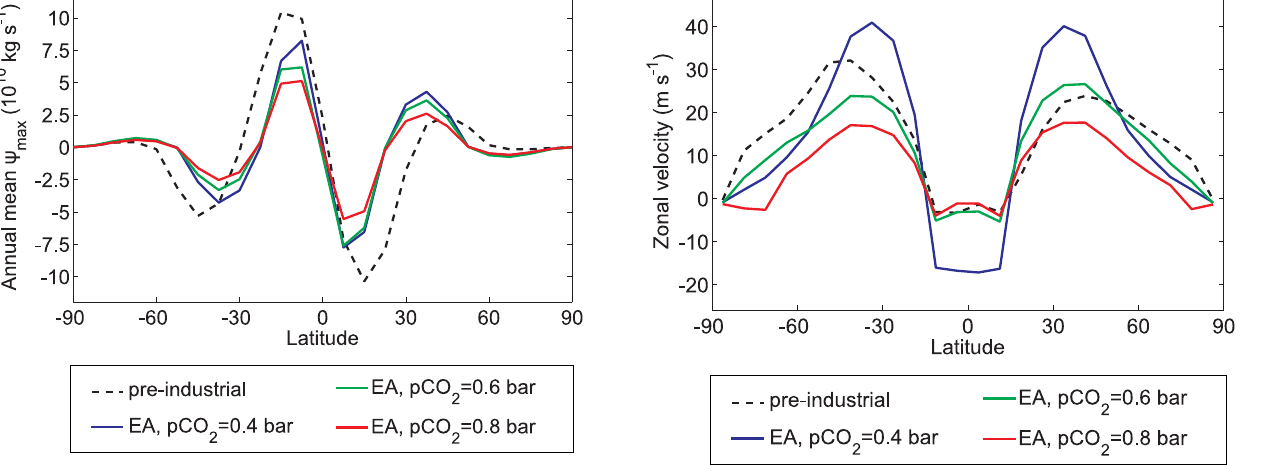
Fig. 12. Latitudinal profile of the annual-mean zonal wind maxima (taken with respect to height) for the pre-industrial state (black) and the three states of the early Archean